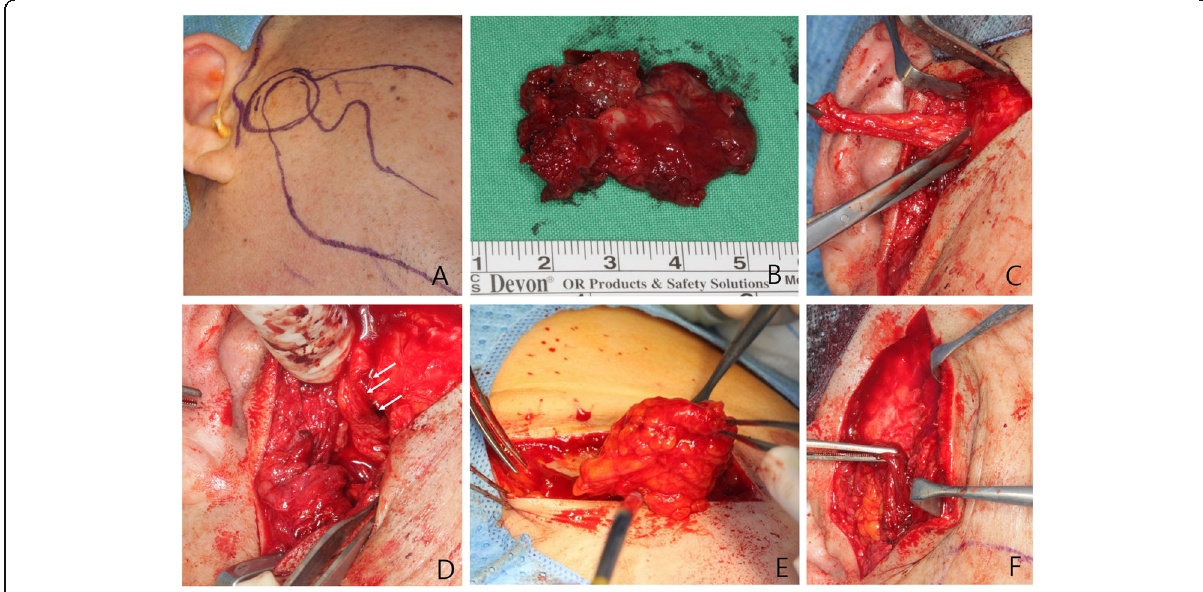
Fig. 2 A The pre-auricular approach, using a hockey-stick incision, is shown. The incision extends anterosuperiorly. B The completely dissected and removed tumor is shown. The largest tumor dimension is 37 mm. C The temporal fascia flap is harvested. D A defect in the anterior wall of the external auditory canal is covered using a temporal fascia flap (arrow). E An inguinal free fat graft is shown. F The inguinal fat graft is covered by a pedicled temporoparietal fascia flap